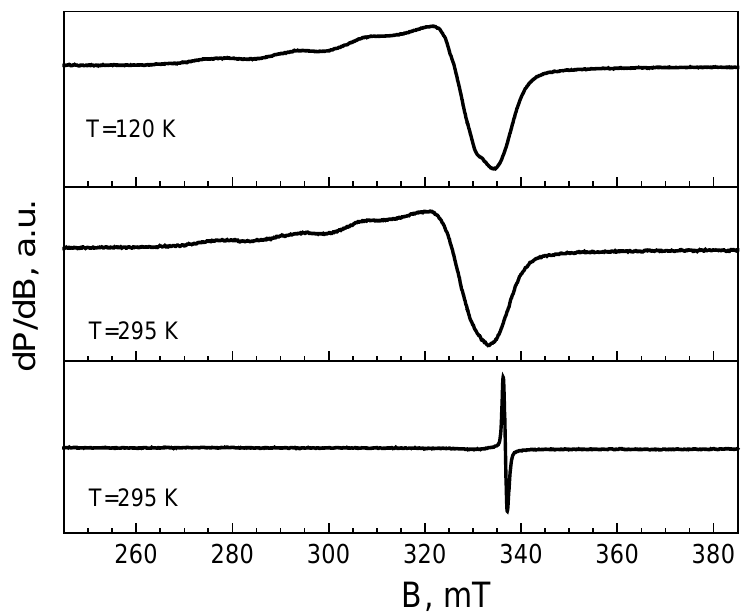
Figure 3. EPR spectra of the complex of [Cu 2 (ACR)(NO 3 ) 2 ]) and dendrimer ligand ACR (bottom). The recording temperature is indicated.